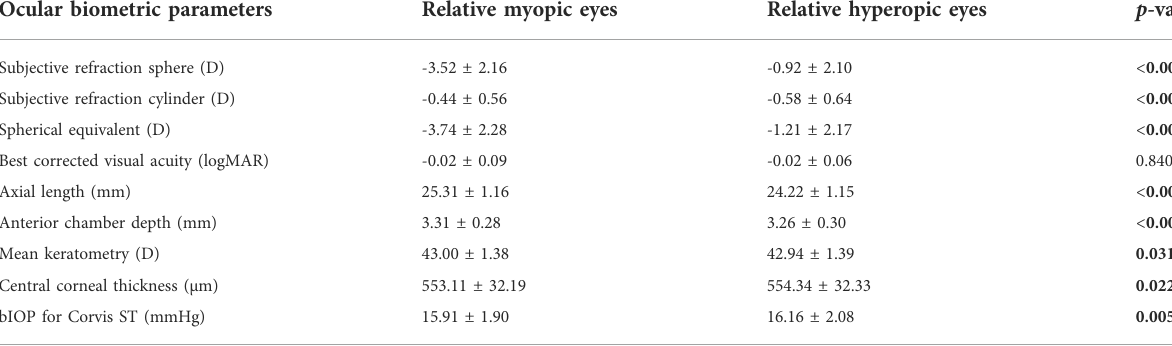
TABLE 3 Ocular biometric parameters for anisometropic fellow eyes. Ocular biometric